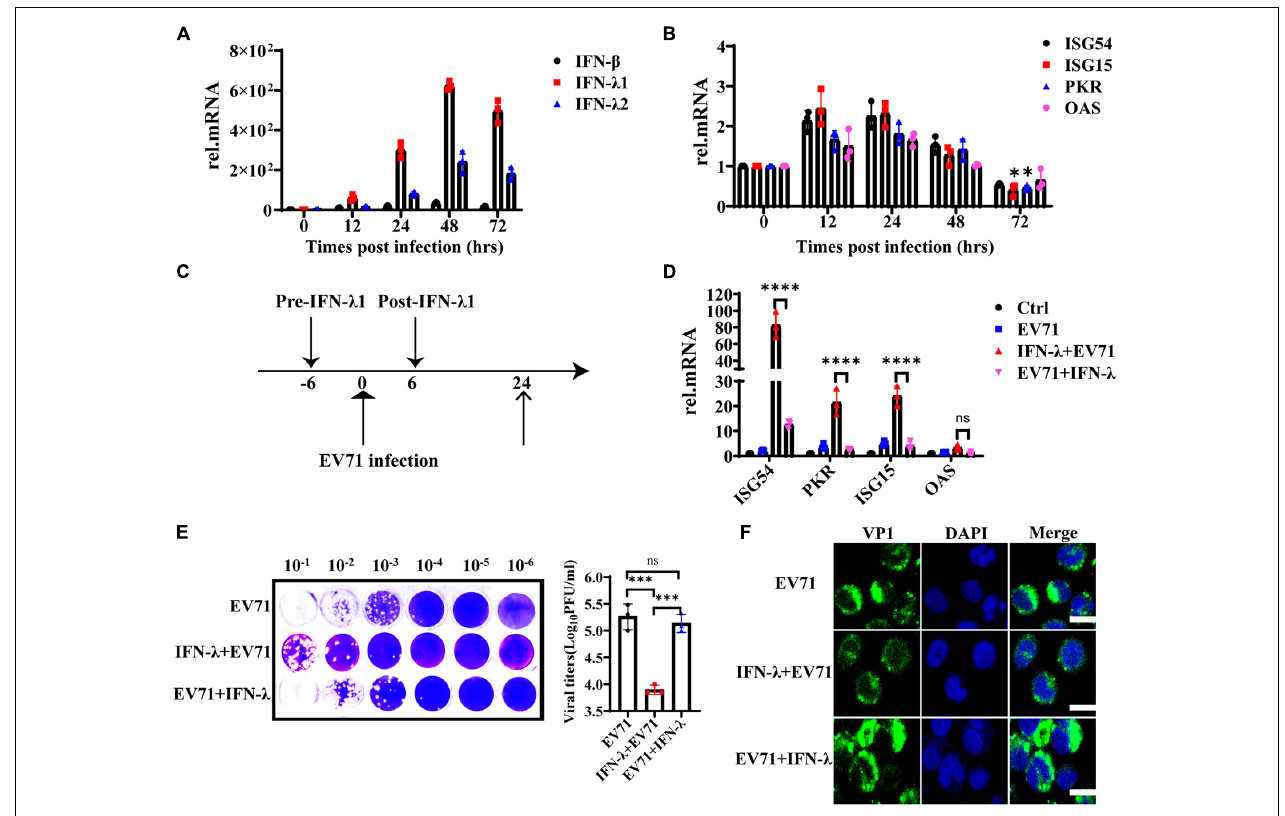
FIGURE 3 | The antiviral function of IFN- λ is antagonized by EV71. (A) HT29 cells were infected with EV71 at an MOI of 1. The expression levels of IFN- β , IFN- λ 1, and IFN- λ 2 were detected at 0, 12, 24, 48, and 72 hpi by qRT-PCR. (B) At the same infection conditions, ISG54, ISG15, PKR, and OAS expression levels were detected by qRT-PCR. (C) Recombinant protein IFN- λ treatment (10 ng/ml) was performed 6 h before infection or 6 h after infection (MOI = 1). (D) After 24 hpi, the cellular RNA was extracted, and ISG54, ISG15, PKR, and OAS expression levels were measured by qRT-PCR. HT29 cells were mock-infected and were not treated by IFN- λ as “control (Ctrl)”. HT29 cells were infected with EV71 as “EV71”. The “IFN- λ + EV71” meant that HT29 was treated with IFN- λ 6 h before infection, and “EV71 + IFN- λ ” meant that HT29 was treated with IFN- λ 6 h after infection. (E) The viral titers in the culture supernatant were monitored by plaque experiments at 24 hpi (F) . The intracellular viral protein (VP1) load was measured by confocal fluorescence microscopy. Dates were presented as mean ± SD ( n = 3 independent experiments, ∗ P < 0.05, ∗∗∗ P < 0.001, ∗∗∗∗ P < 0.0001 and ns, not